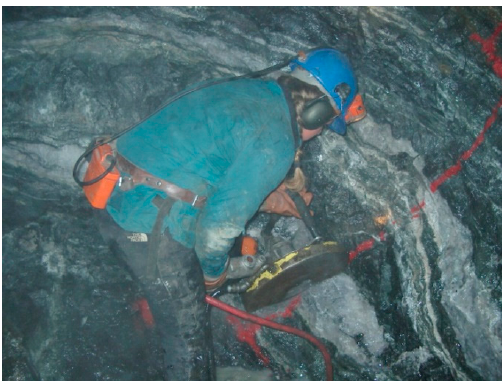
Figure 8. Diamond saw in operation during the exploration/evaluation phase.